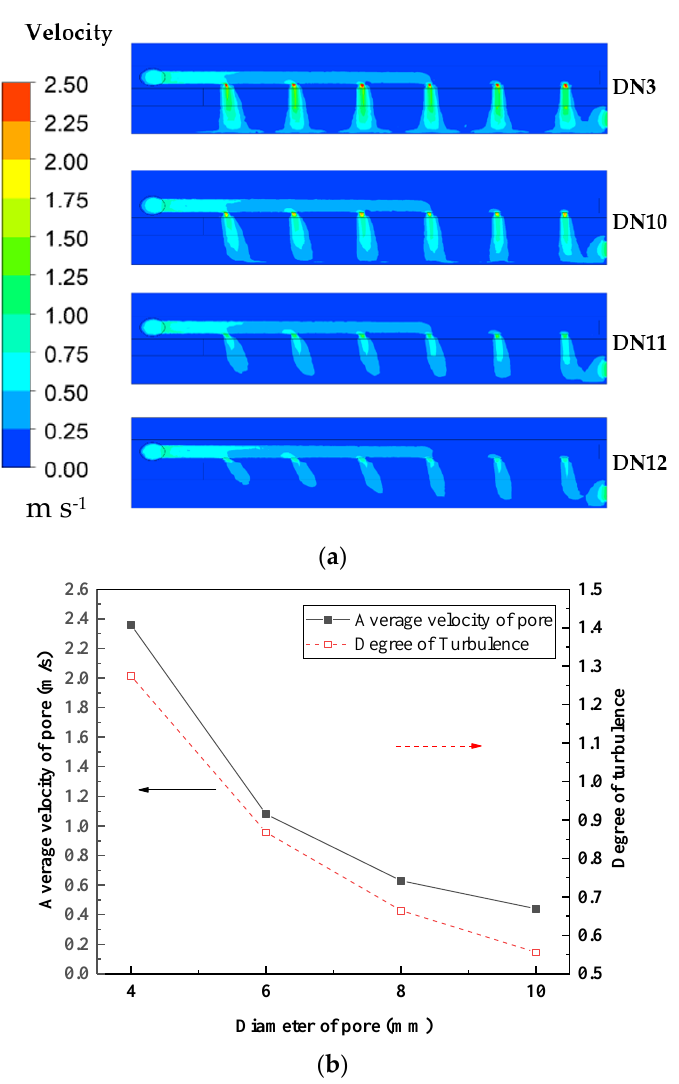
Figure 8. ( a ) Distribution of the velocity at the middle x–y plane of the branch pipe and ( b ) the average velocity and degree of the turbulence for the water diffuser under different perforated pore diameters.